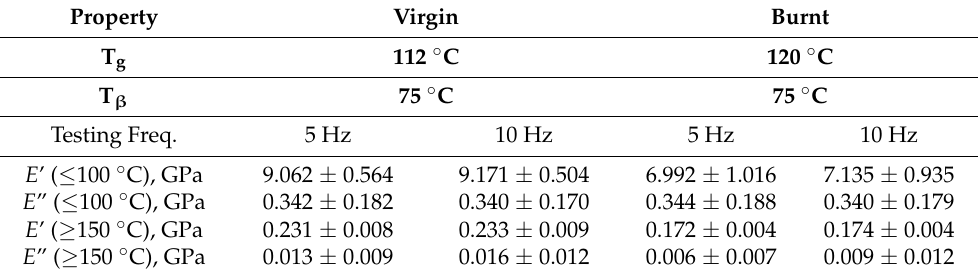
Table 2. Summary of the properties extracted from dynamic mechanical analyzer (DMA)